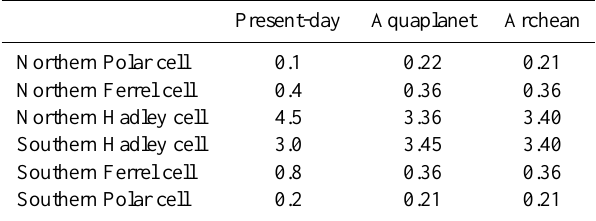
Table 1. Empirical C i -factors for the parameterization of the atmo- spheric meridional cell strength in terms of the temperature field. Present-day values are from the standard version of CLIMBER-3 α , and aquaplanet values are based on a comparison with modelling re- sults by Marshall et al. (2007). For the Archean, we have chosen the factors in the last column which are close to the aquaplanet values, but symmetrical about the equator. Present-day Aquaplanet